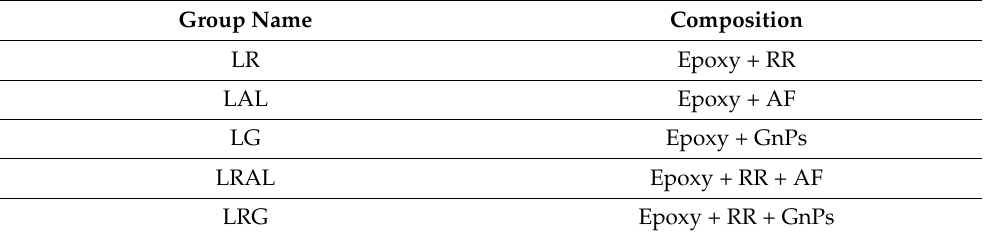
Table 7. Characterization of recycled rubber composites reinforced with AFs and GnPs